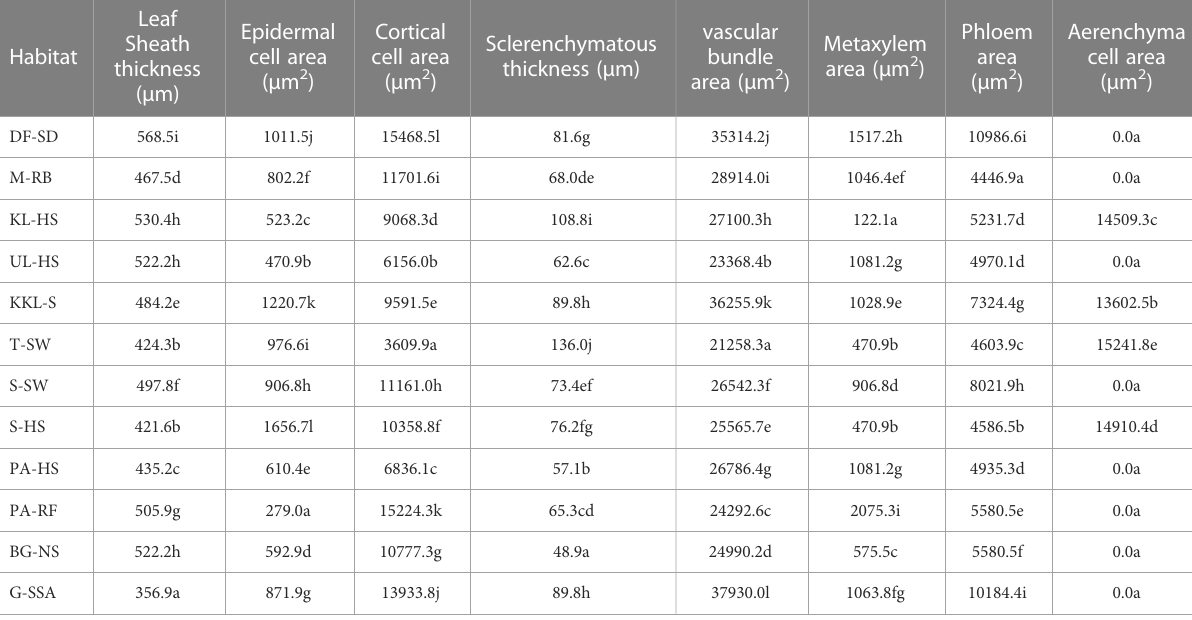
TABLE 5 Leaf sheath anatomical characteristics of the selected habitats from Punjab, Pakistan.